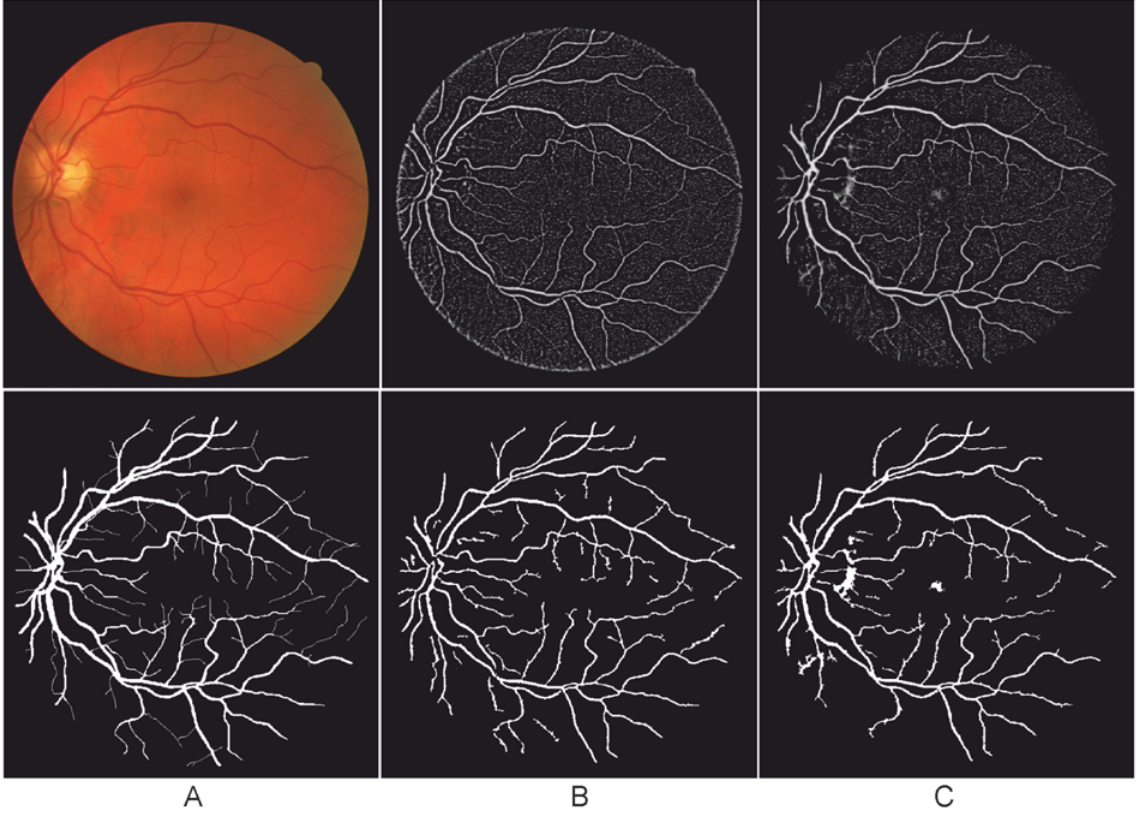
Fig 5. Relative importance of Retinex-based inhomogeneities correction. (A) A randomly chosen image from the DRIVE dataset and expert ’ s annotation. (B) Vesselness map using local phase filter (top), and the segmentation result (bottom) when the Retinex is applied. (C) Vesselness map using local phase filter (top), and the segmentation result (bottom) when the Retinex is not used.